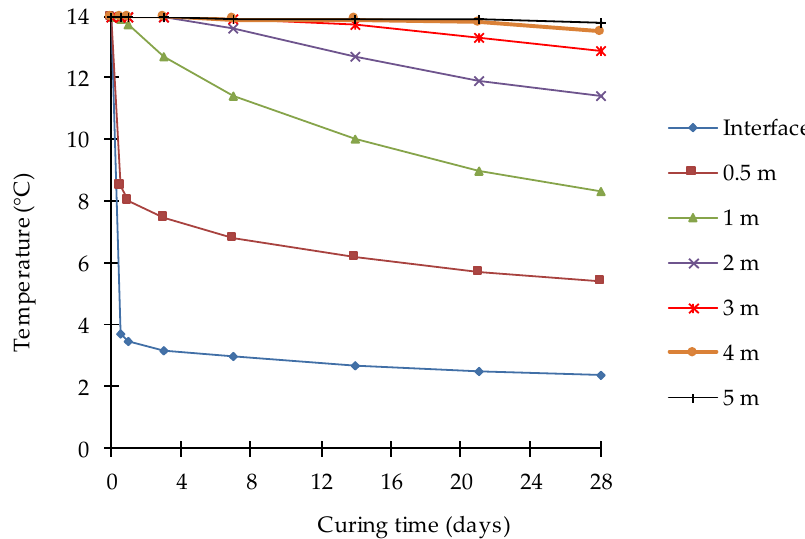
Figure 10. Typical temperature evolution over 28 days in the CPB at distances of 0 (interface), 0.5, 1, 2, 3, 4, and 5 m from the CPB–permafrost wall interface.